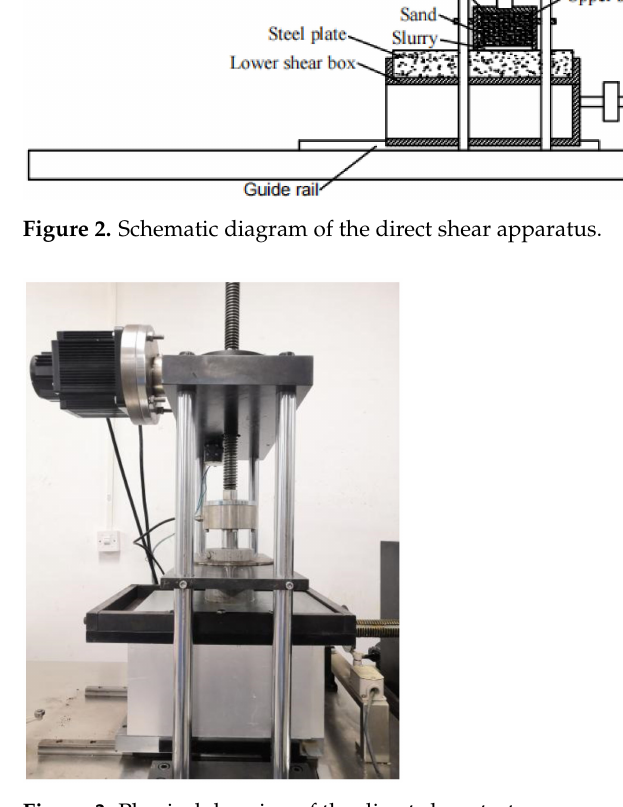
Figure 3. Physical drawing of the direct shear